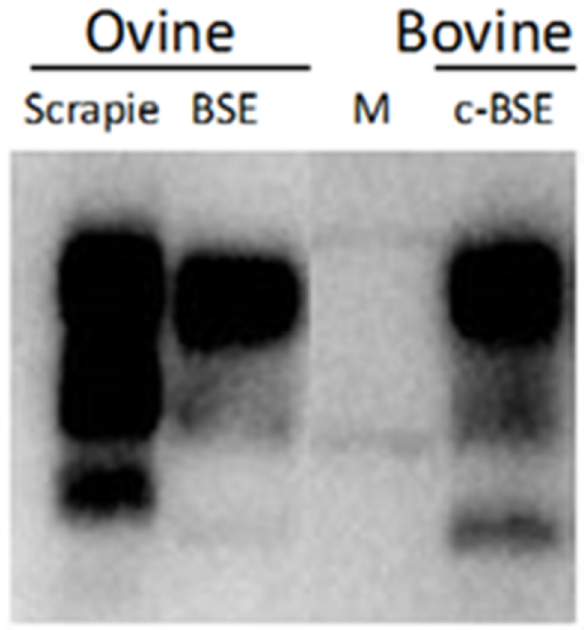
Figure 5. Western blot detection of PrP res from proteinase K-treated and ultracentrifuged brain homogenates, using a core antibody. Ovine scrapie, ovine BSE, and bovine C-type BSE are shown. The lower molecular weight of the unglycosylated protein band in ovine or bovine BSE compared to scrapie is evident. M-molecular mass markers 20 and 30 kDa. Reprinted from Ref. [79].